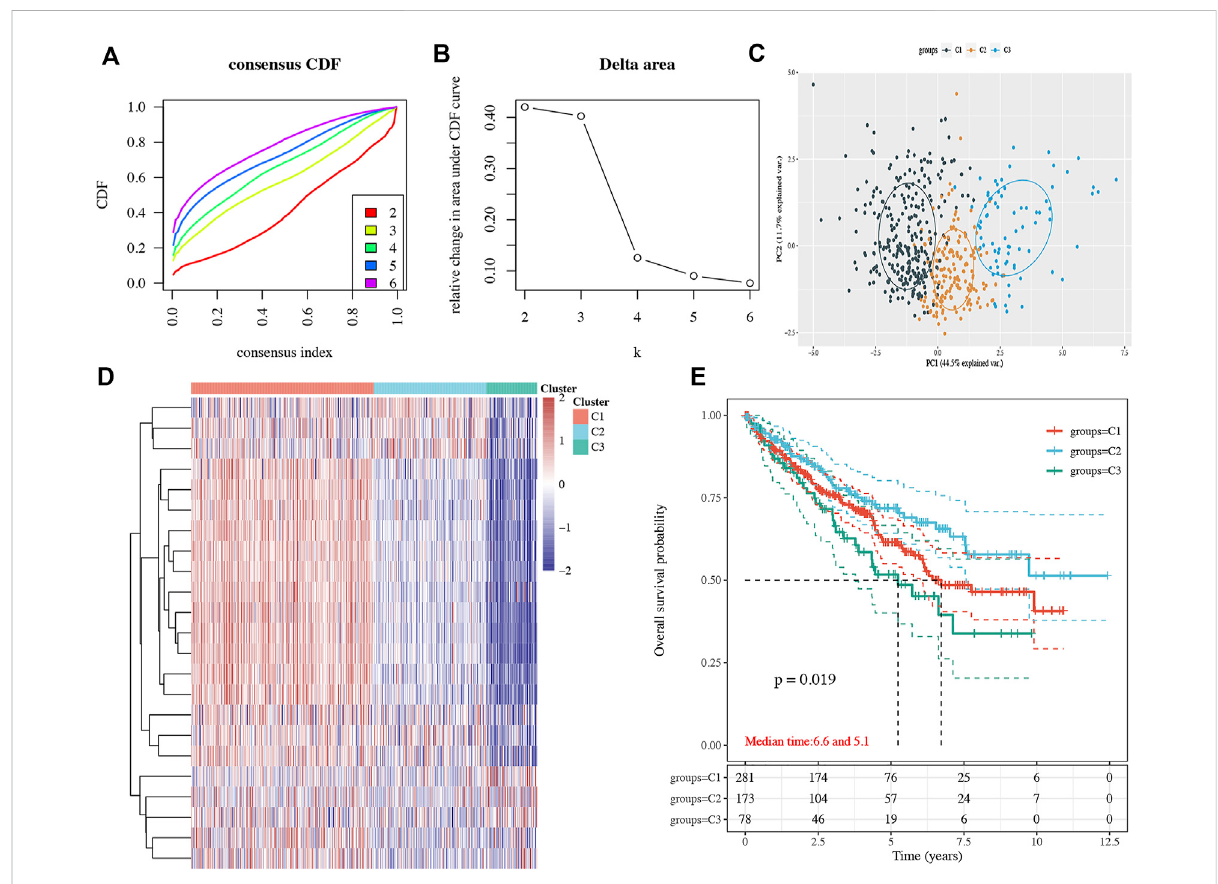
FIGURE 3 Subtype analysis inccRCC based on NET-related genes. (A – B) CDF and deltaarea under theCDF curvein consensus clustering analysis. (C – D) Three subtypes of TCGA ccRCC cases were identi fi ed according to the consensus clustering matrix. (E) Overall survival curve of each cluster of ccRCC patients. ccRCC, clear cell renal cell carcinoma. CDF, cumulative distribution